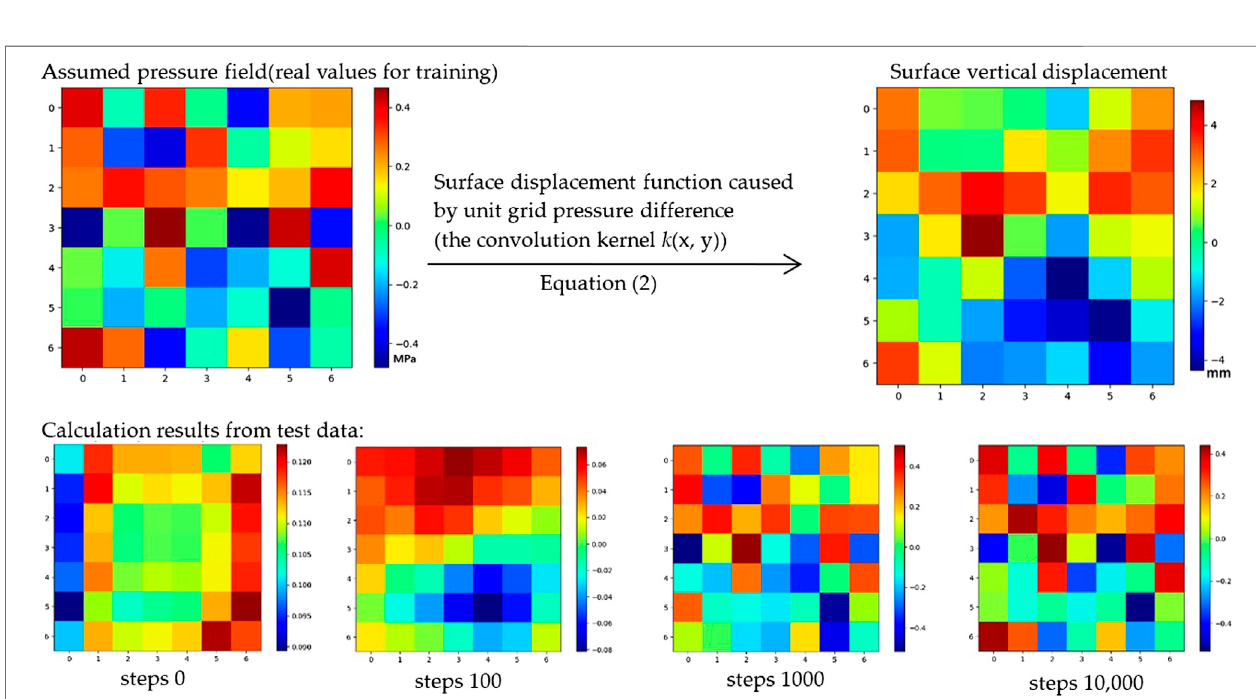
FIGURE 10 | Formation pressure changes of the fi rst sample compared with the prediction of different training iterations. In step 100,000, the formation pressure change values of each grid in the fi gure are not different from the real values.